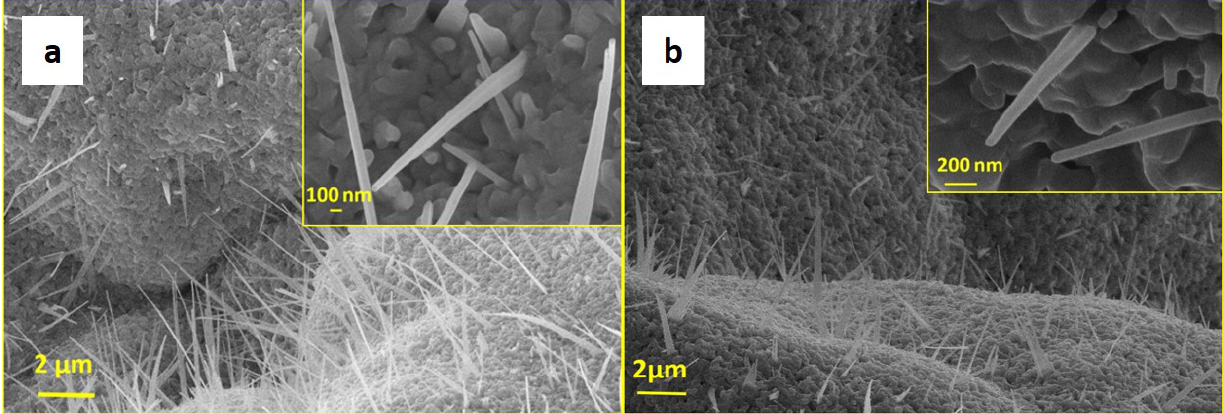
Figure 1. ( a ) Scanning electron microscopy (SEM) micrograph of sample A; ( b ) SEM micrograph of sample B-Sn. Insets show the details of single nanowires (NWs) at high magnification.